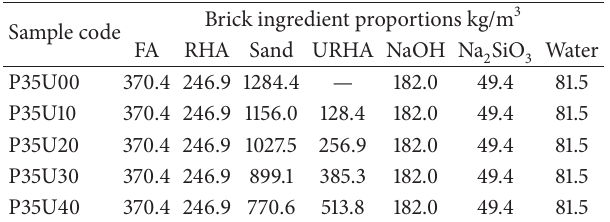
Figure 4: SEM image of URHA particles. Table 3: Mixture proportions for the production of ecofriendly construction